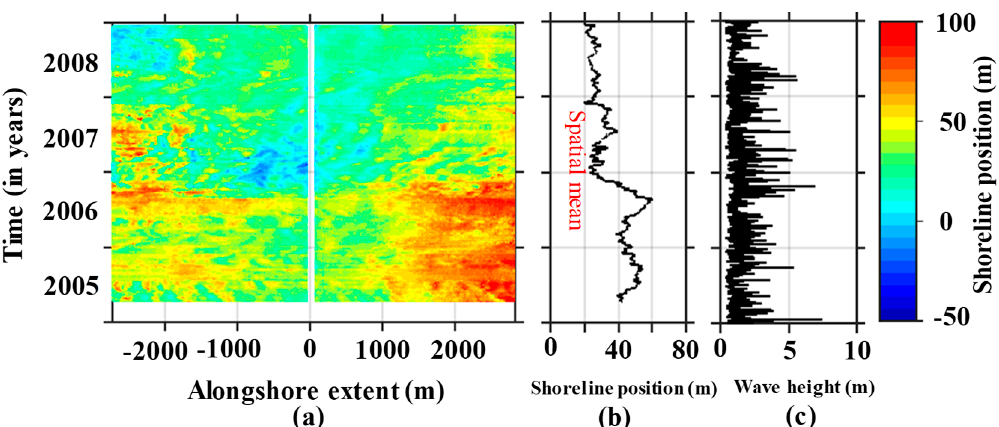
Figure 24. ( a ) Gaps in the shoreline positions derived by mTWM with corrected wave run-up filled by Garcia’s smoothing and gap-filling method. (b) The spatial means of shoreline positions. ( c ) The temporal variations of significant wave height.